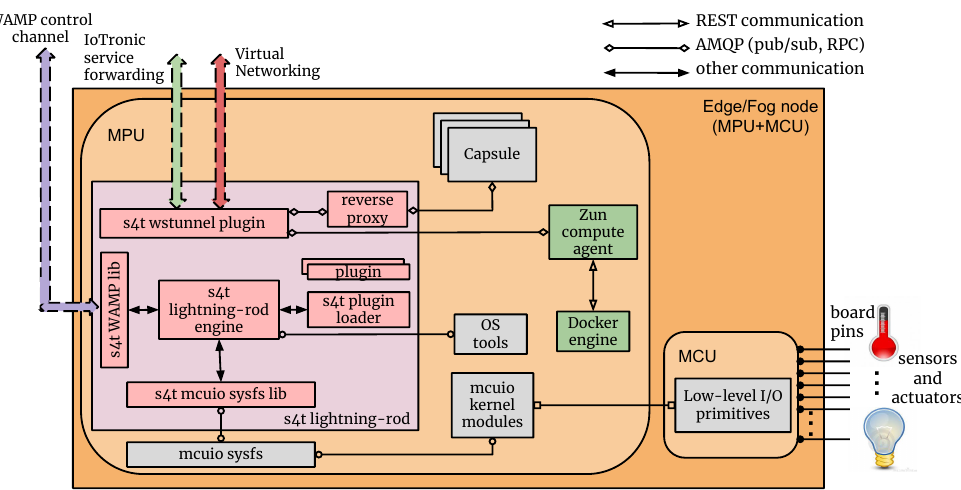
Figure 8. S4T FaaS system